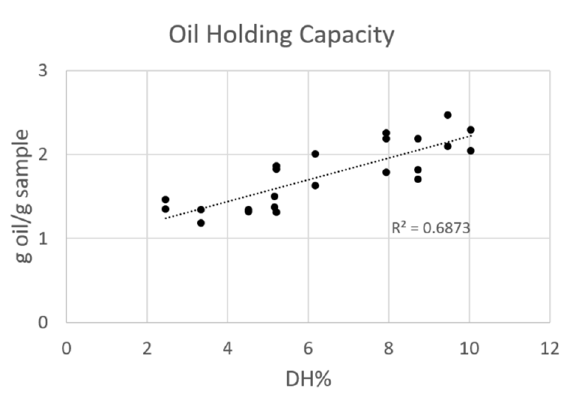
Figure 4. Oil holding capacity of the different hydrolysates and controls produced expressed as g oil/g sample in function of DH%. The analysis was done in triplicate.